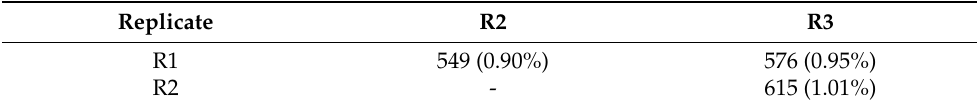
Table 6. Error numbers between each replicate of